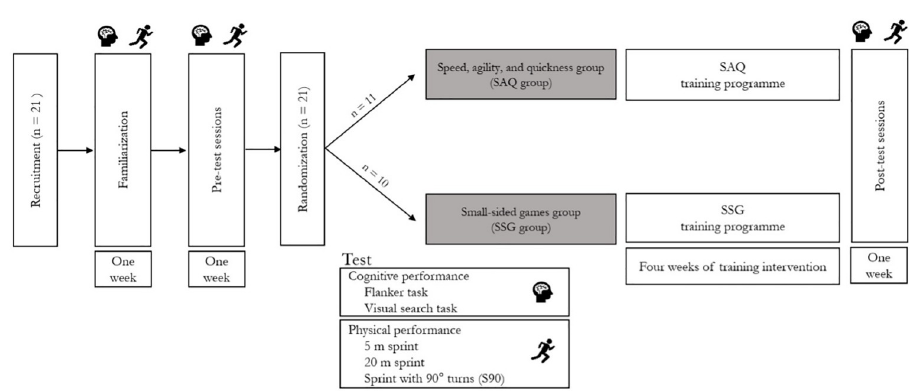
Fig 1. Overview of the experimental